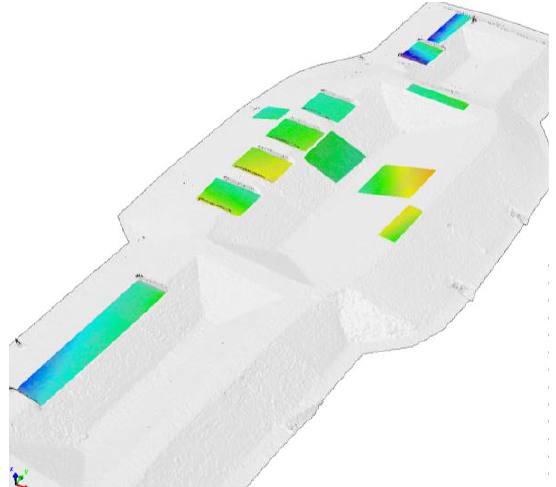
Figure 6. Segment 4 (view from south)